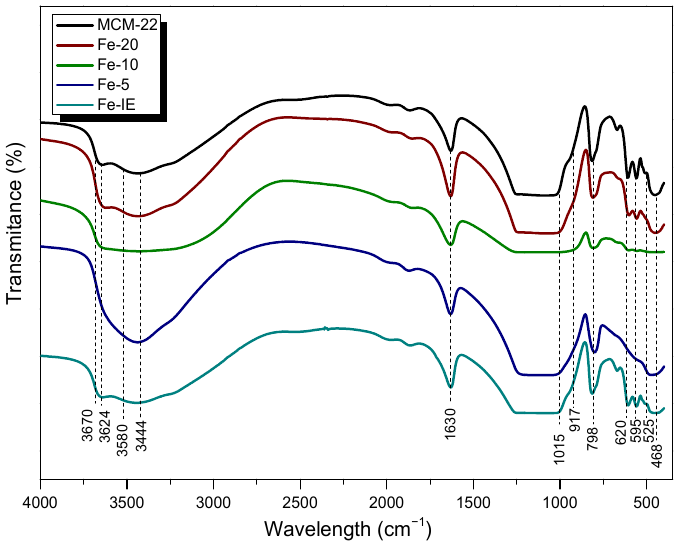
Figure 8. FT-IR spectra obtained for the samples.